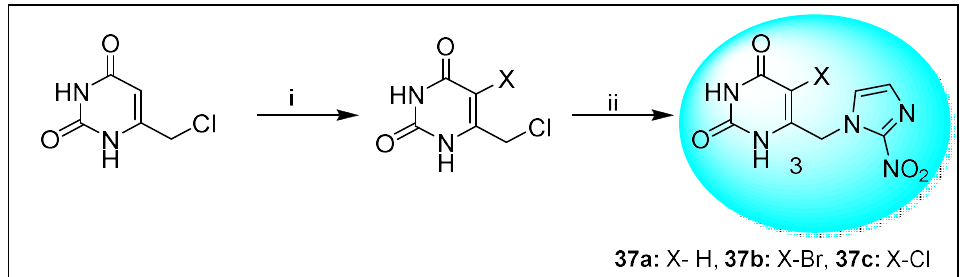
Cole et al. (2003) developed the 2-nitroimidazolylmethyluracils 37a – c and 2-aminoimidazolylmethyluracils (Scheme 11) as inhibitors of thymidine phosphorylase (TP). In this study, the authors identified 2-aminoimidazolylmethyluracils as potent TP inhibitors with IC 50 values of ~20 nM as compared with 2-nitroimidazolylmethyluracil (as bio-reductively activated) prodrugs ( 37b / 37c ), which were 1000-fold less active with IC 50 values ranging from 22–24 μM [73].